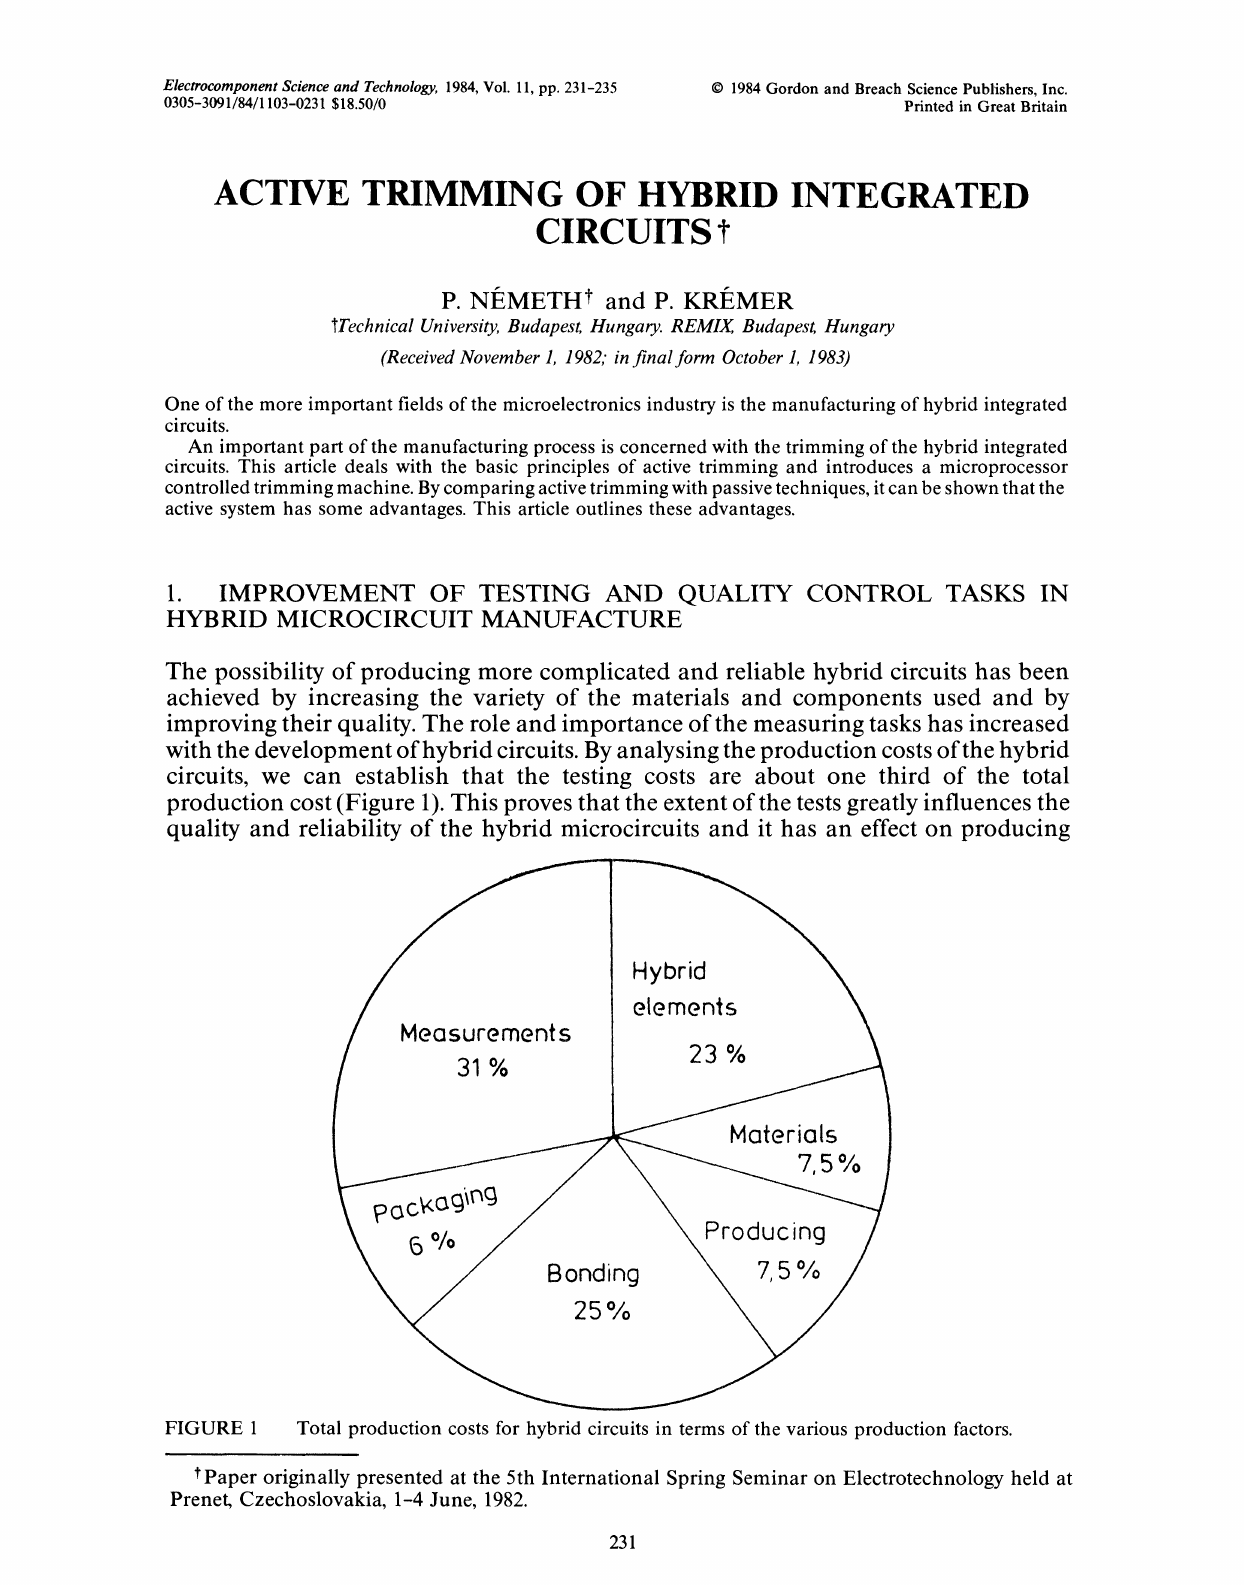
Total production costs for hybrid circuits in terms of the various production factors. *Paper originally presented at the 5th International Spring Seminar on Electrotechnology held at Prenet, Czechoslovakia, 1-4 June, 1982.